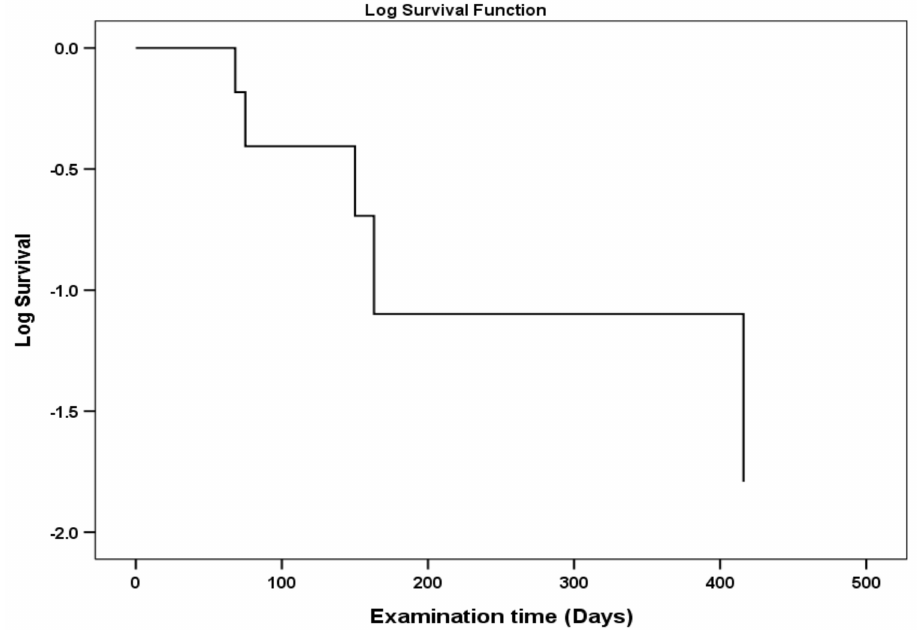
Figure 3. Kaplan–Meier curve asserted the assumption the independence of the data failure. The longest time a patient used the in-ear device was about 400 days.